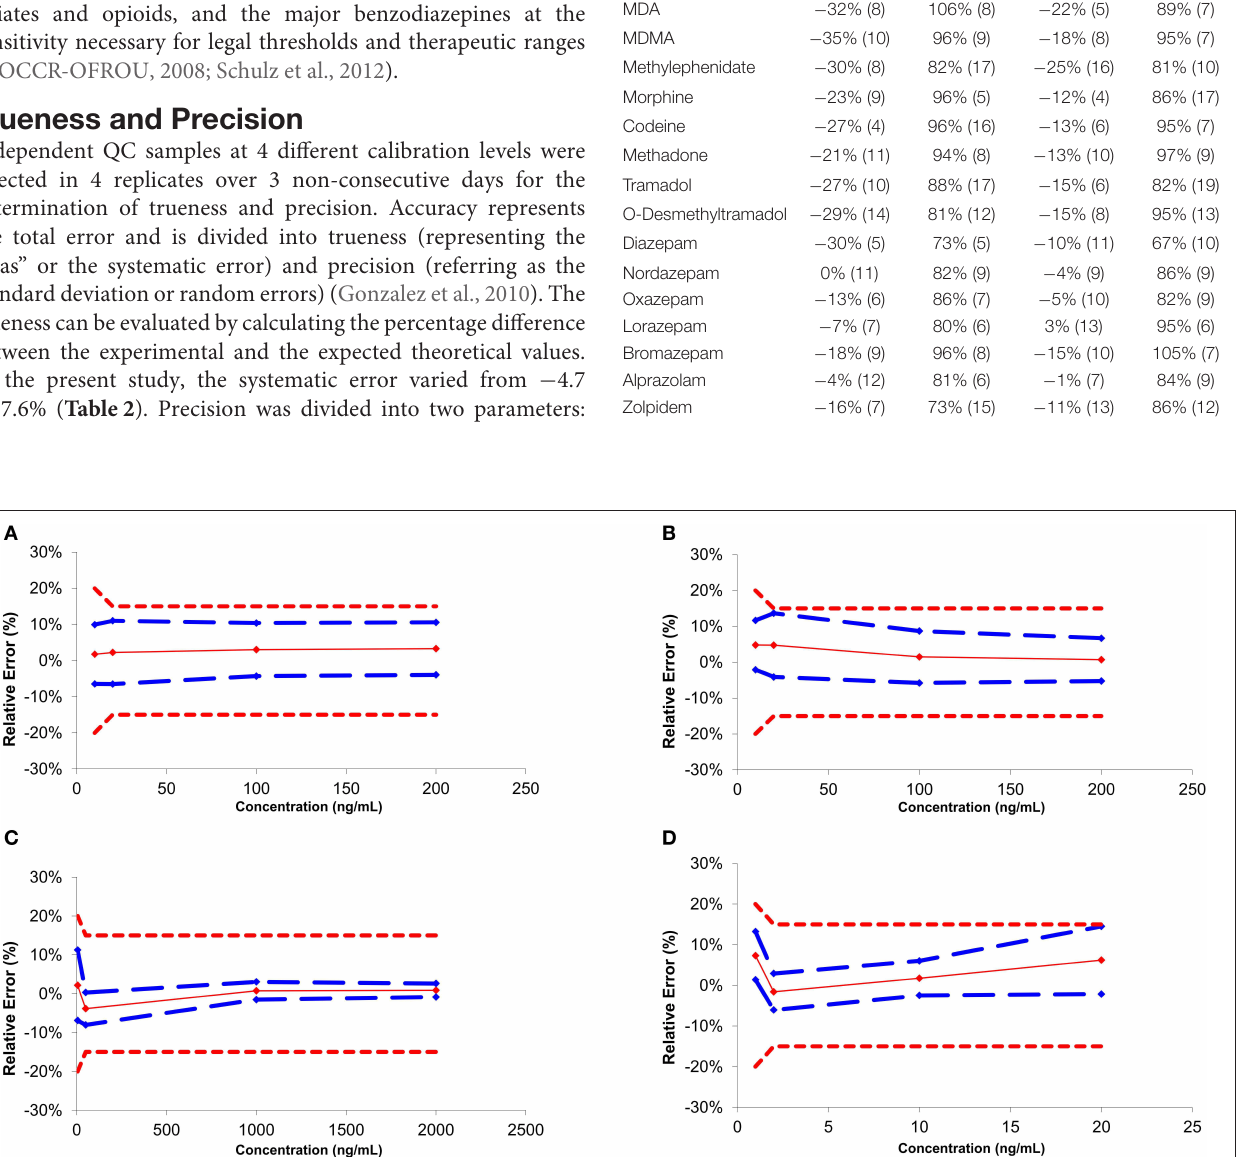
Frontiers in Chemistry |